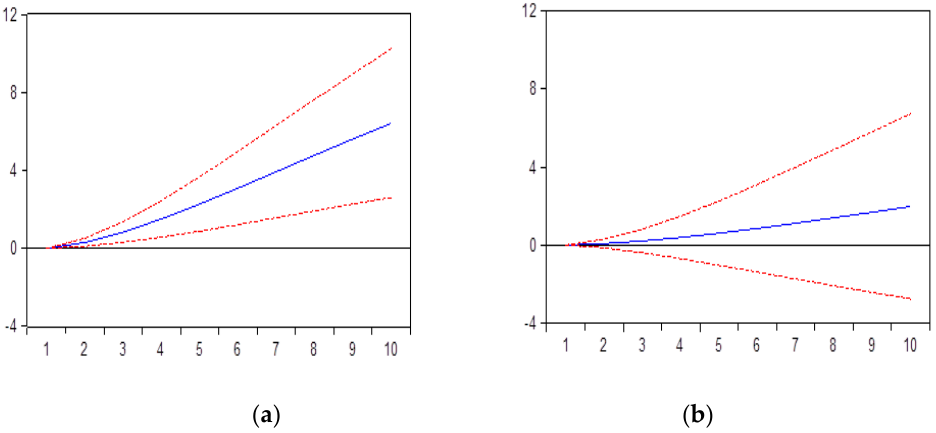
Figure 1. a (left) and b (right). Impact of internet usage and employment in knowledge intensive Figure 1. ( a ) Impact of HI to IU; ( b ) Impact of HI to KI. Impact of internet usage and employment in activities on individuals searching for health-related information. knowledge intensive activities on individuals searching for health-related